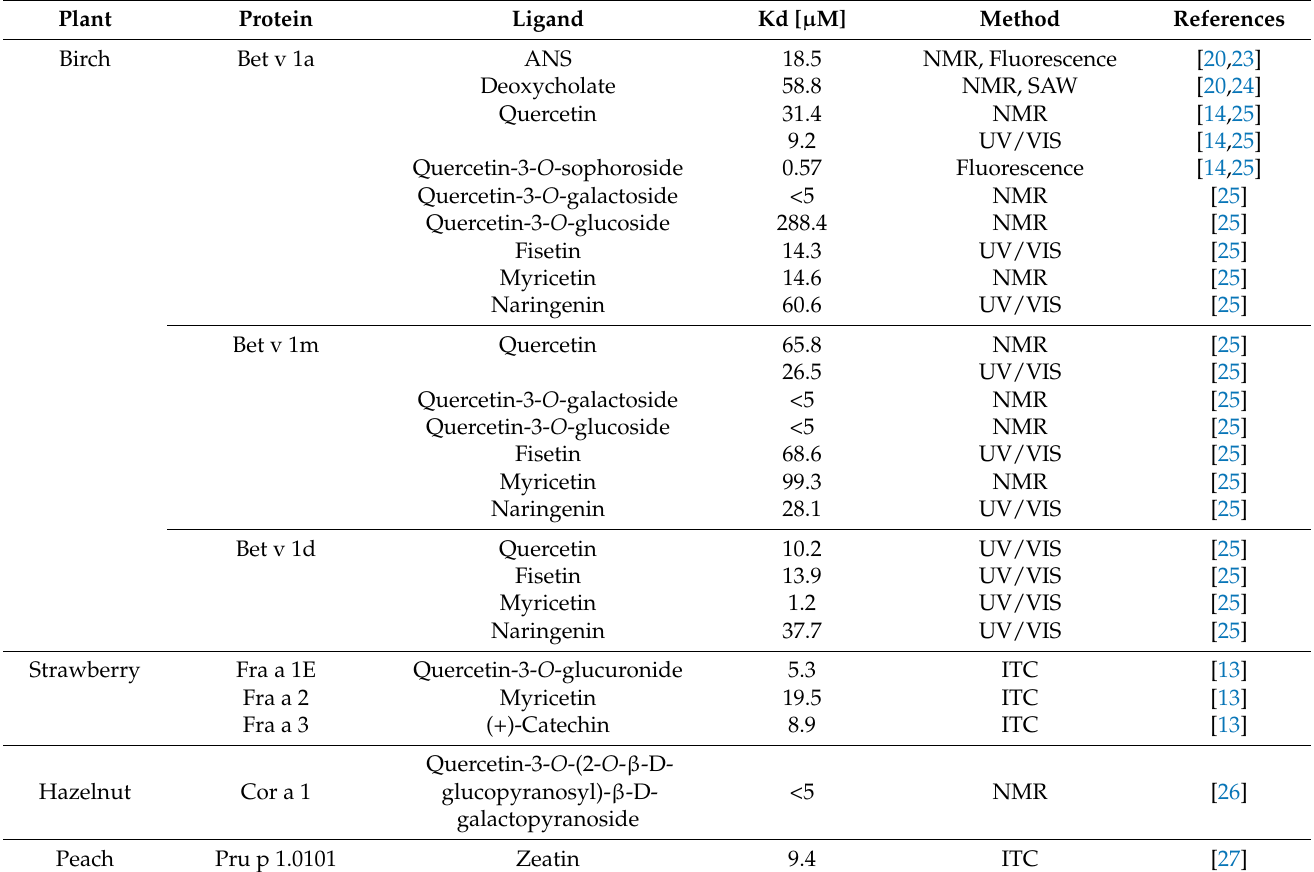
Table 1. Identified ligands of PR-10